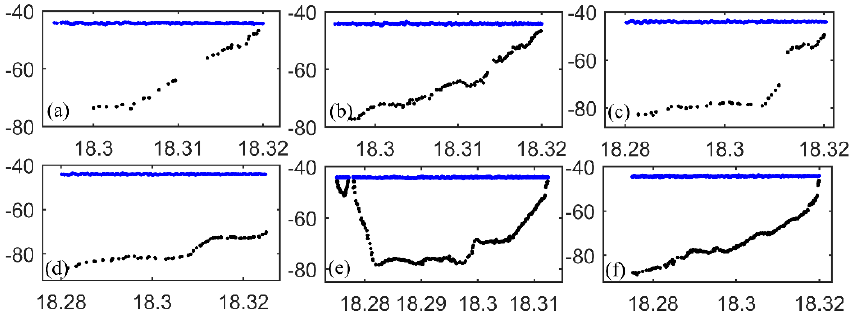
Figure 12. Detection results of reflected photons on the sea surface and seabed in the St. Thomas area; ( a ) 20181122GT1L; ( b ) 20181122GT1R; ( c ) 20181122GT2R; ( d ) 20181122GT3R; ( e ) 20190221GT1L; ( f ) 20190221GT2L.